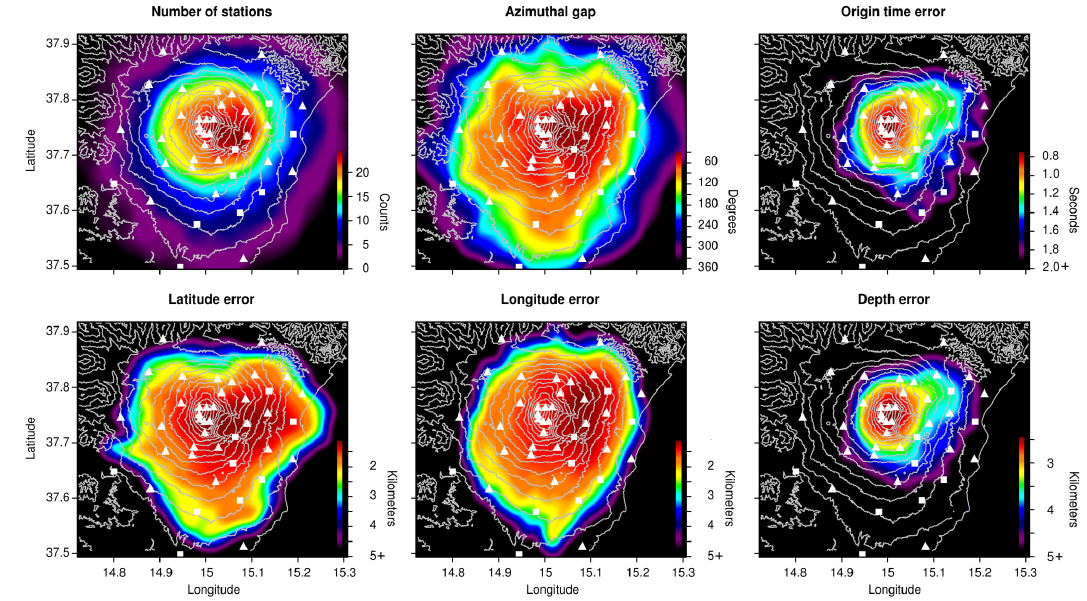
Fig. 6. SNES maps for ESN + CS at M L 1.5, hypocentral depth of 5km and confidence level of